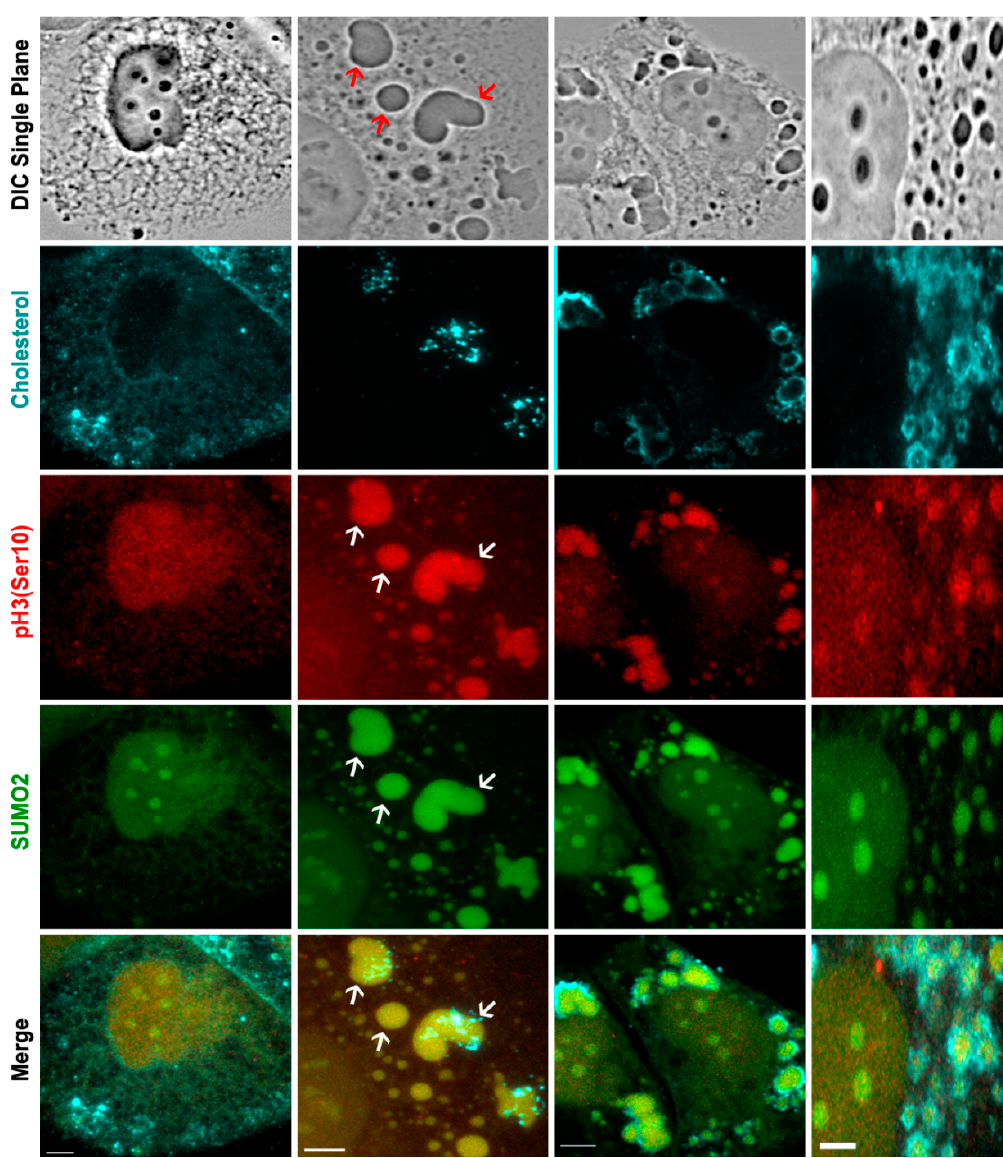
Figure 8. SUMO2-conjugated pH3(Ser10) shows liquid–liquid phase separation (LLPS) in the cytoplasm of tumour cells exposed to acute hypoxia. Cells were subjected to treatment conditions for 96 h. Zoomed images obtained through high-resolution confocal microscopy showed liquid–liquid phase partitioning of SUMO2-pH3(Ser10) in the cytoplasm of hypoxia exposed cells. An example of LLPS is indicated by red arrows in the DIC images and white arrows in the colour images. The LLPS-like regions showed punctate staining of cholesterol around the periphery, indicating that these membraneless aggregates were surrounded by membranous organelles.